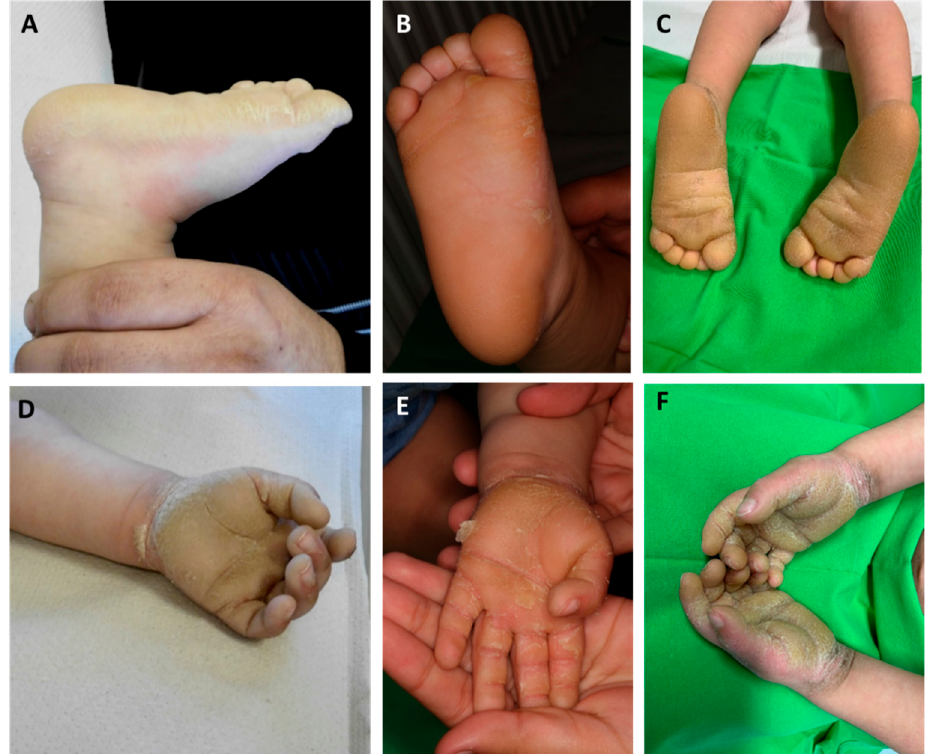
Figure 2. Palmoplantar keratoderma of the patient at the age of 6 months ( A , D ), 1 year ( B , E ), and 3 years ( C , F ). Extension of hyperkeratosis beyond the palmoplantar margins can be observed. In our case, the severity of palmoplantar keratoderma (PPK) showed changes over time.